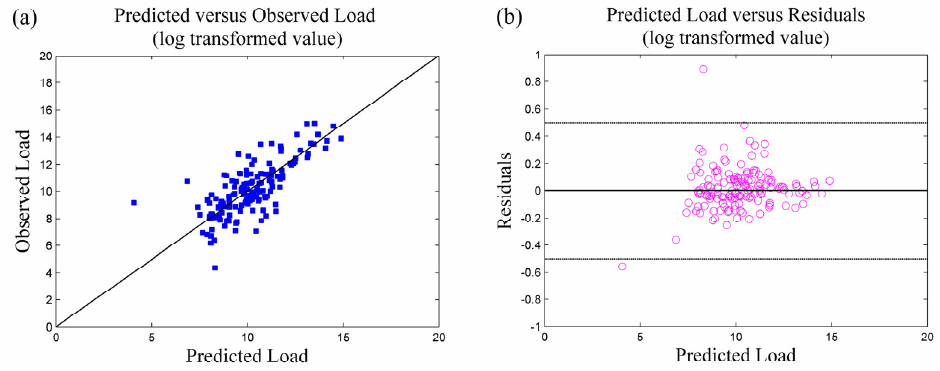
Figure 6. Scatterplots of ( a ) predicted values versus observed values and ( b ) residuals in HRB.